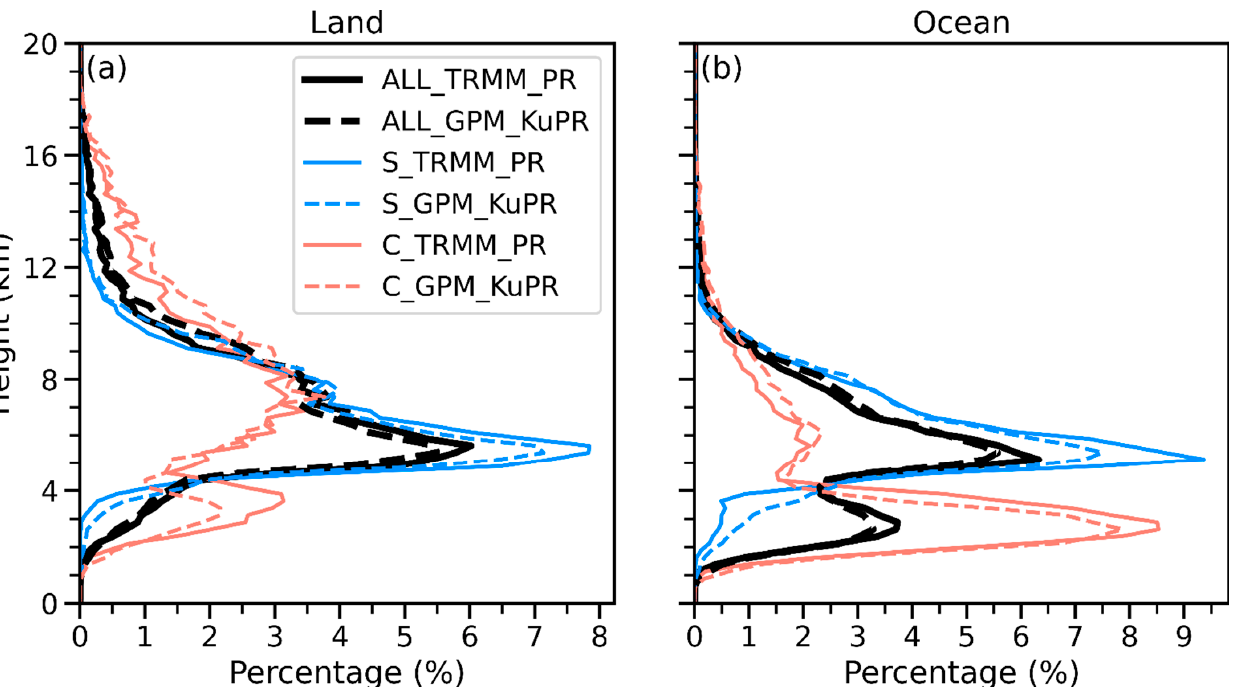
Figure 6. The probability distribution functions (PDFs) of coincident Topht20s from the TRMM_PR (solid lines) and GPM_KuPR (dashed lines) over ( a ) land and ( b ) ocean. Black, blue, and red lines represent all, stratiform, and convective rain types, respectively.